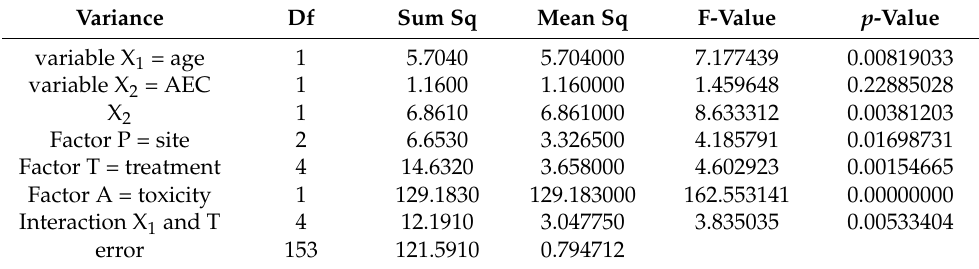
Table 5. Analysis model of covariance.